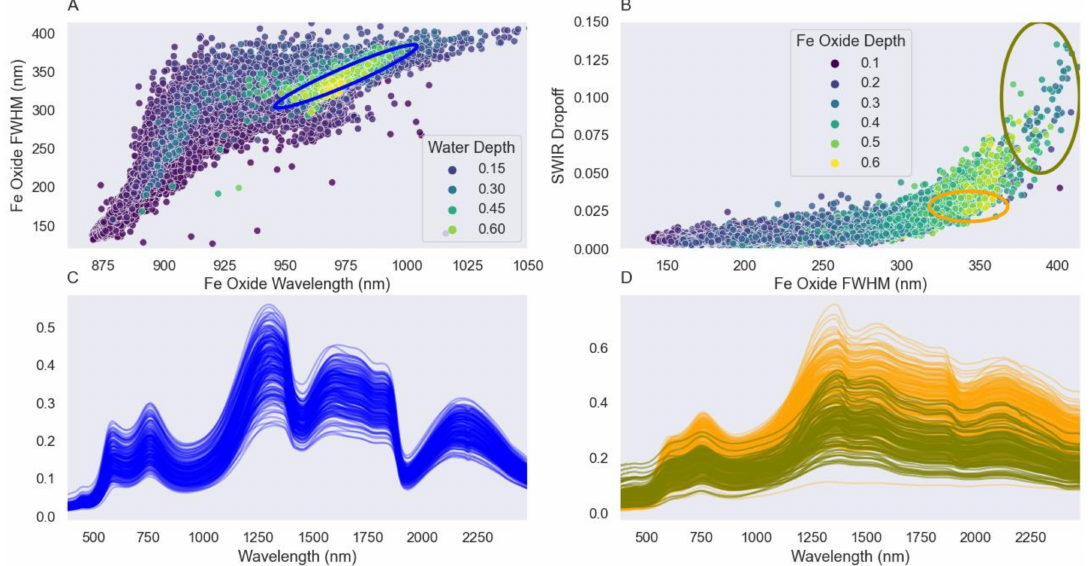
Figure 6. ( A ) is for the entire SWIR Masked datasets and coloured by the water depth. The spectra in ( C ) are extracted by selecting samples with a water depth metric greater than 0.6 and shown approximately circled in ( A ) and represent the Rocklea Dome CID spectra. ( B ) is the Fe oxide FWHM plotted against the SWIR dropoff for the Hamersley Basin the second diamond core dataset (Core 2, BIF). ( B ) is coloured by the Fe oxide depth for visualisation discrimination only but does show an increase in Fe oxide depth with increasing goethite and decreasing hematite. The olive is primarily vitreous goethite ( D ), while the orange region highlighted in ( B ) is representative of mixed vitreous and ochreous